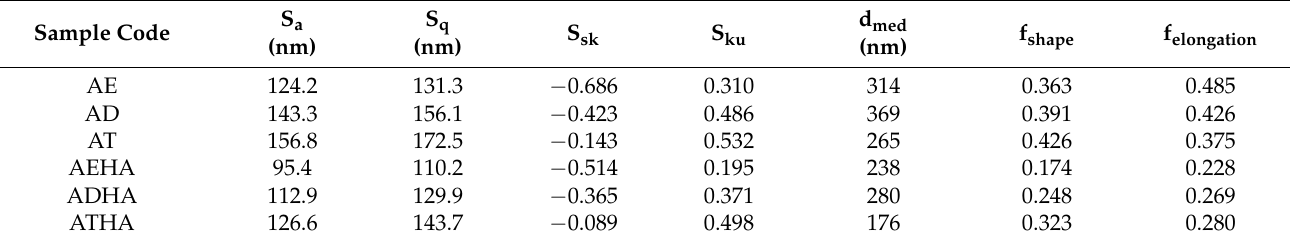
Figure 8. AFM images (2D) and cross-section profile of AE and AEHA microparticles. Table 5. Surface profile parameters for precursor/hybrid microparticles.